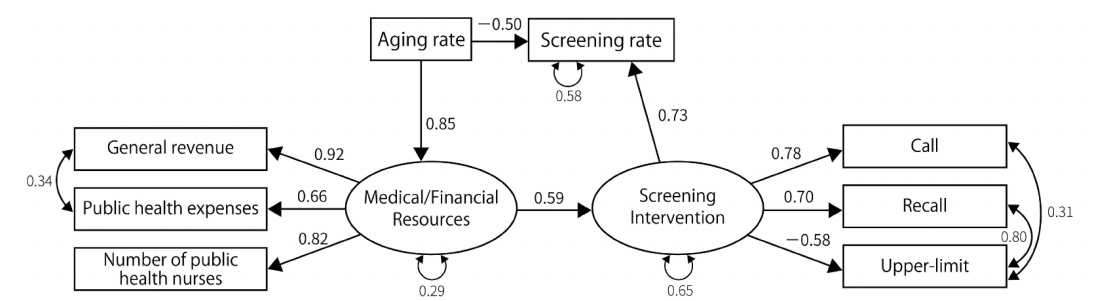
Figure 5. The final model for cervical cancer. GFI = 0.909, AGFI = 0.782, PGFI = 0.379, SRMR = 0.095, CFI = 0.896, RMSEA = 0.168, p -value by χ 2 test = 0.003, χ 2 = 34.798, degrees of freedom = 15.